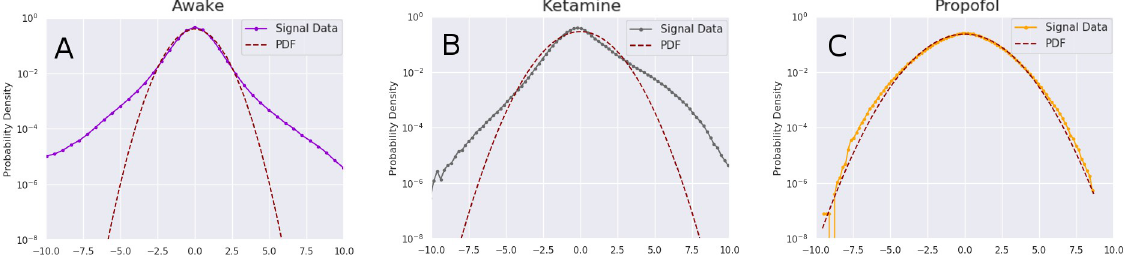
Fig 2. Examples of raw EEG timeseries visualized. Visualization of five seconds of all 128 channels for each condition. Top: awake, middle: ketamine, bottom: propofol. Images taken from EEGLAB (v.14.1.2) [42]. Note that the time-series are un-normalized, with scales ranging from 464-515